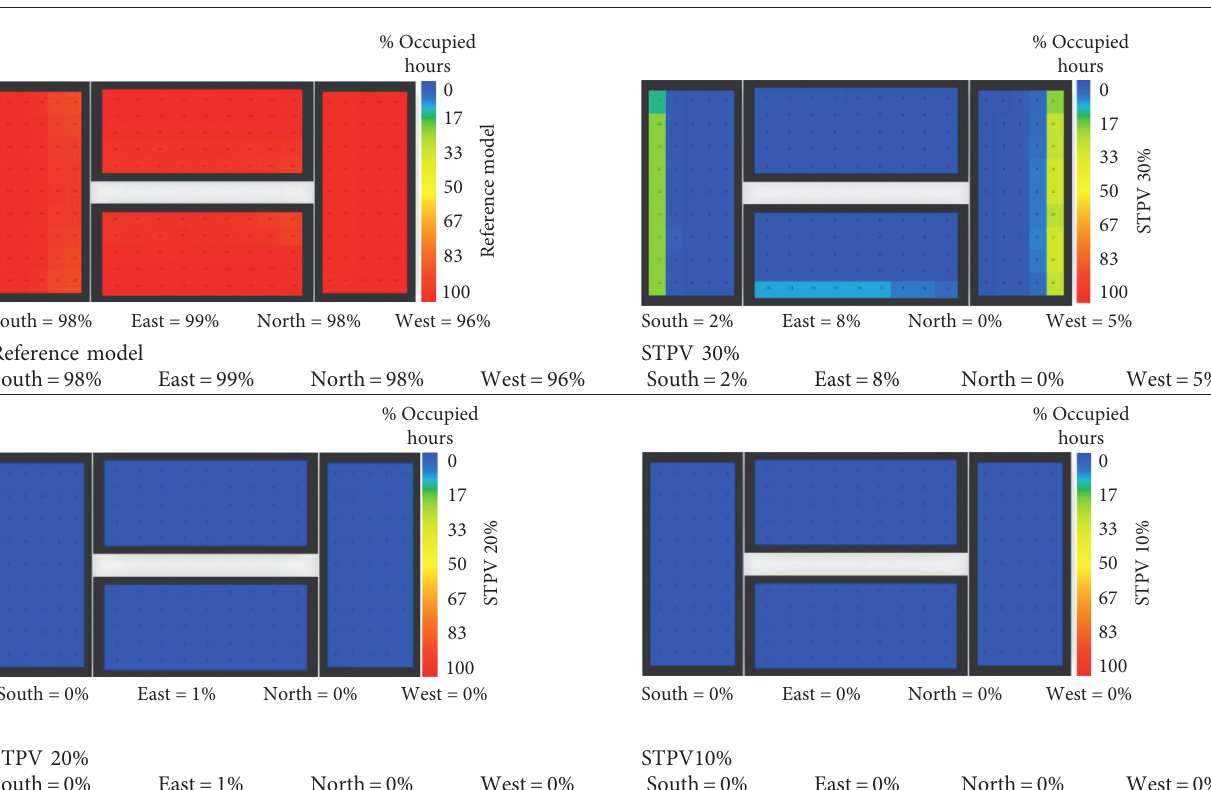
Table 11: DA300 lux distribution of fully glazed open office in cardinal orientations (Kuala